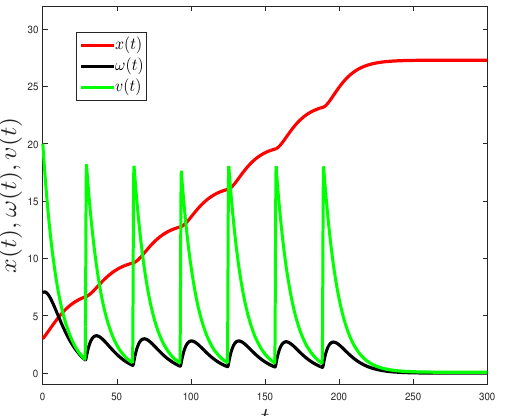
Figure 5. State dynamics for the system with irrigation, time t in days, where v ( t ) (green line), ω ( t ) (black line), and x ( t ) (red line) are the water available in the soil, the water inside the plant, and the amount of dry matter, respectively. Parameter values: x ( 0 ) = 3.0, ω ( 0 ) = 7.0, v ( 0 ) = 20.0, κ = 0.01, g = 0.1, m = 0.00001, δ = 1.0, r = 20, β = 0.1, k = 0.01, γ = 0.000009, ρ =